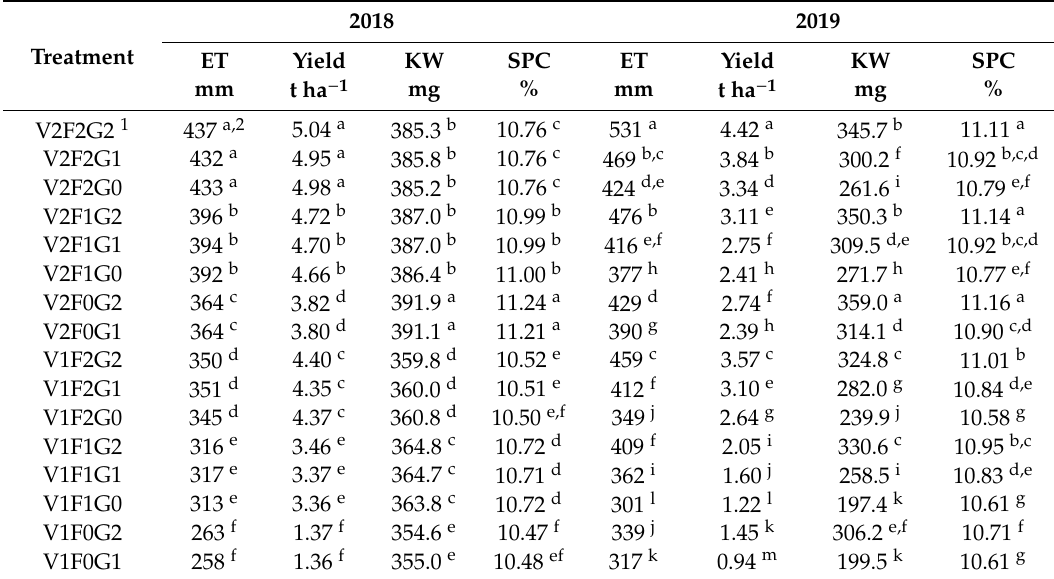
Table 4. Evapotranspiration (ET), yield, kernel weight (KW), and seed protein content (SPC) of hybrid maize seeds under di ff erent irrigation treatments in 2018 and